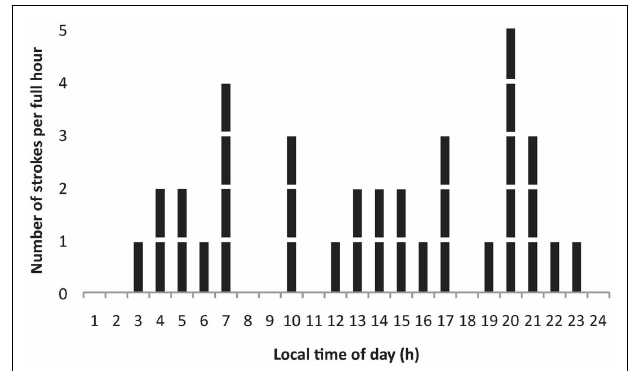
FIGURE 2 | Distribution of the number of strokes by time of day in 35 (13 female) stroke patients . Most strokes per hour were observed at 07:00 and 20:00h.